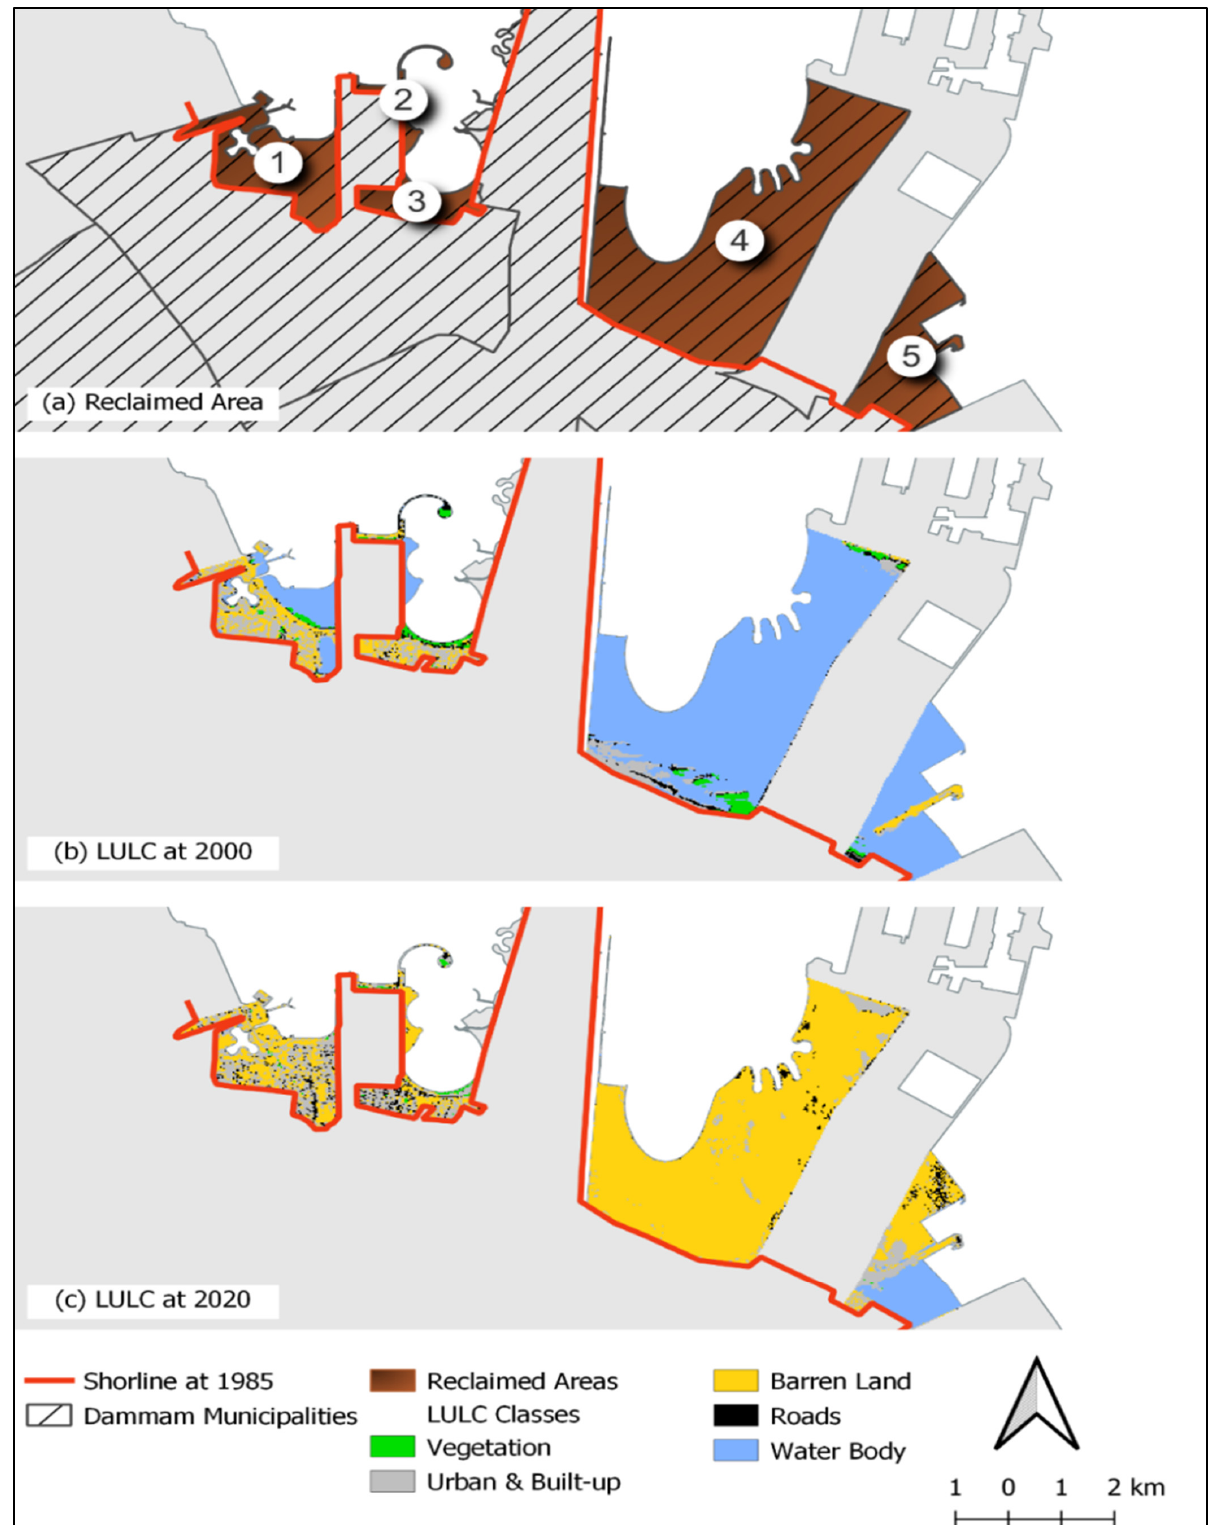
Figure 4. Reclaimed areas and LULC Classifications: ( a ) Reclaimed areas as obtained from the official shoreline vector, ( b ) LULC classification results for 2000, and ( c ) LULC classification results for 2020.